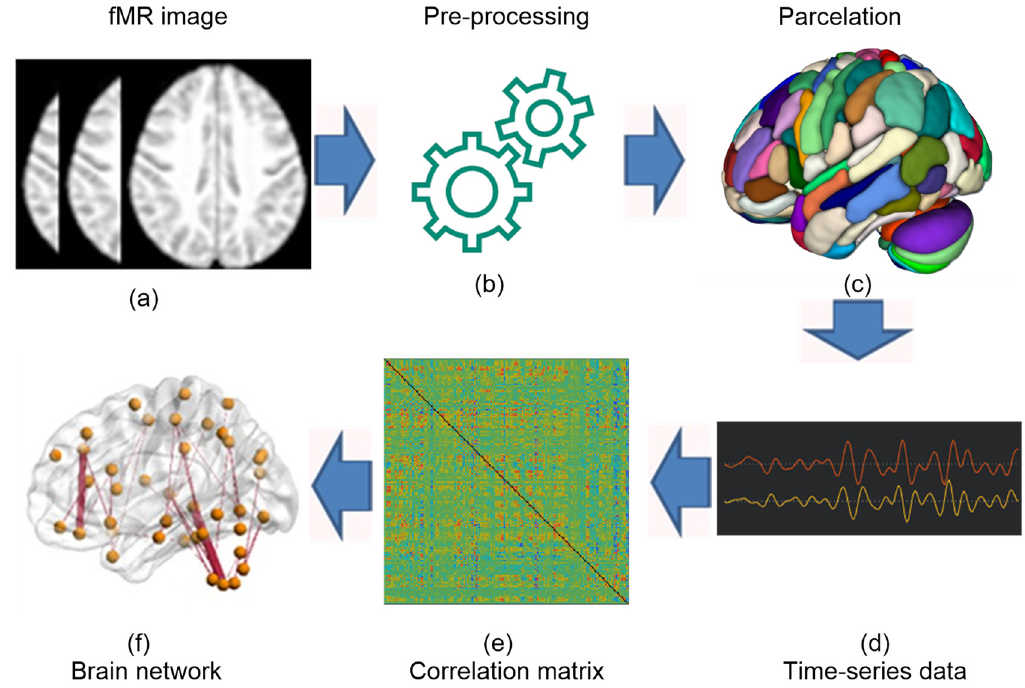
Figure 1. Flowchart for the construction of functional brain network.